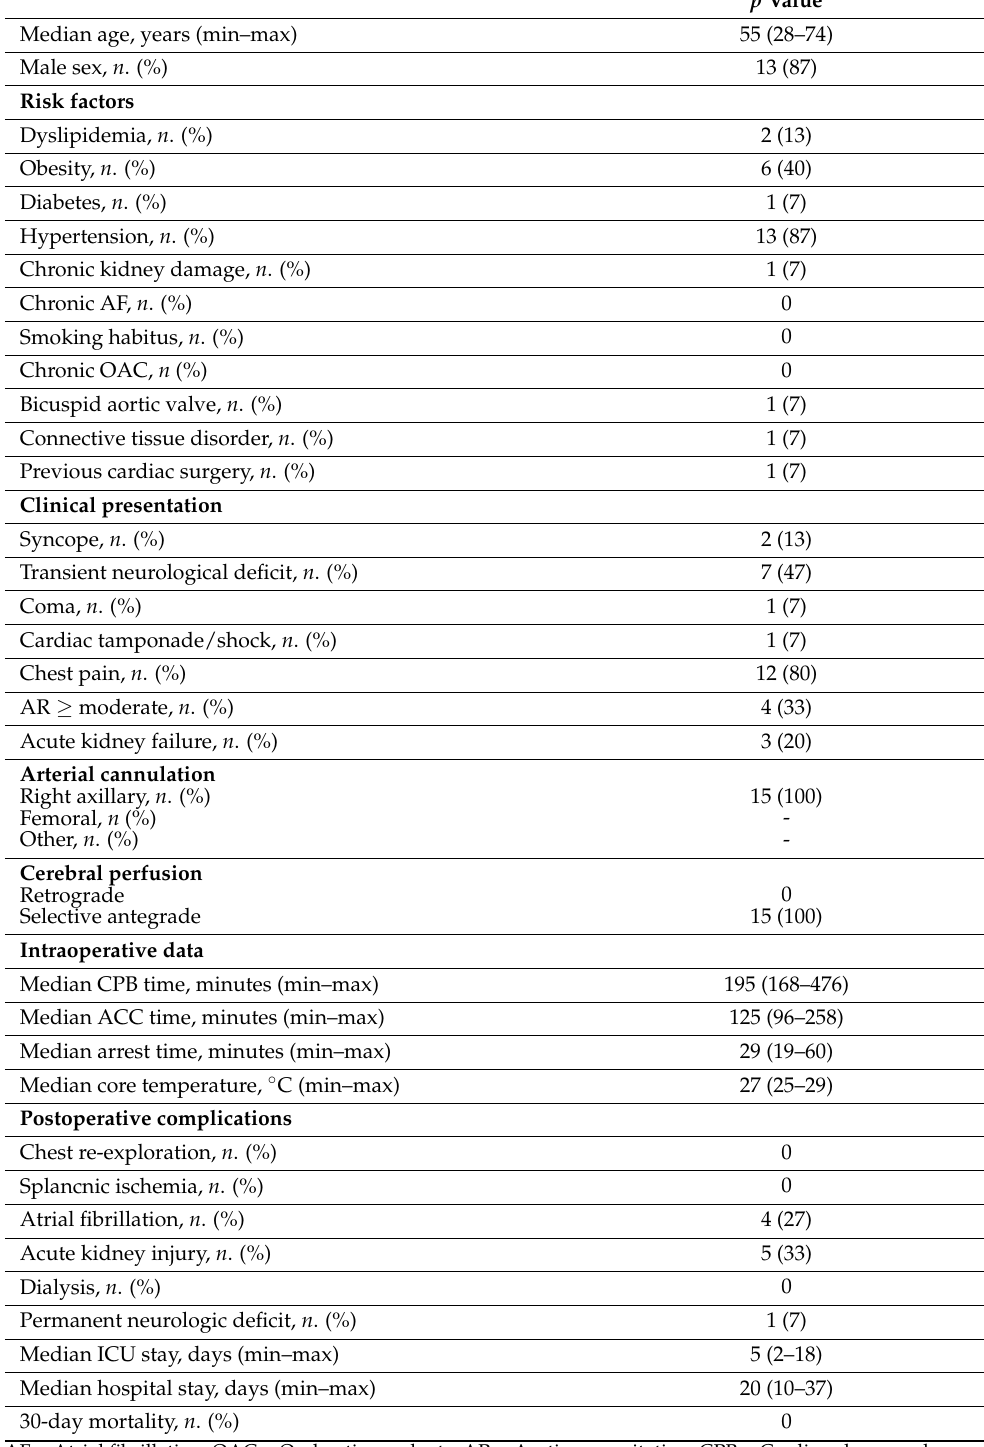
Table 4. Characteristics of patients having a frozen elephant trunk procedure ( n =